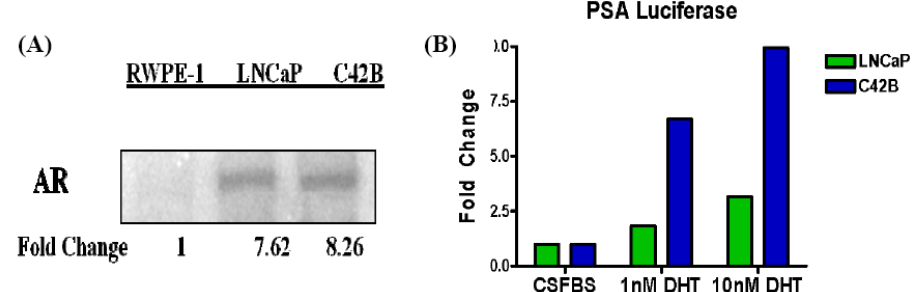
Figure 7. Differential regulation of AR-directed transcription in DHT stimulated